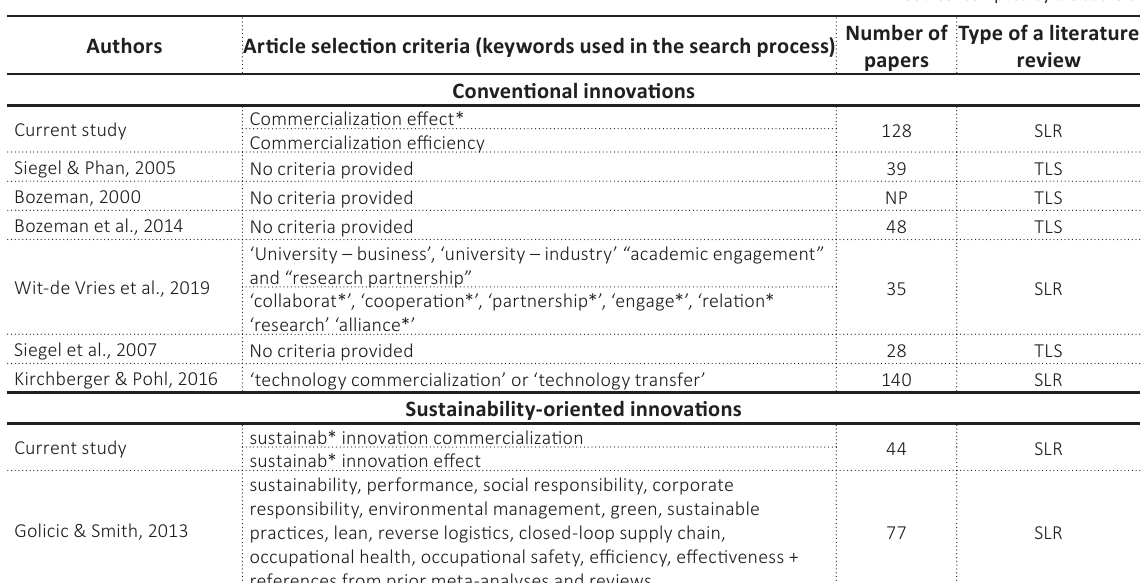
Table 1. Comparison of keywords, number of articles and type of literature review